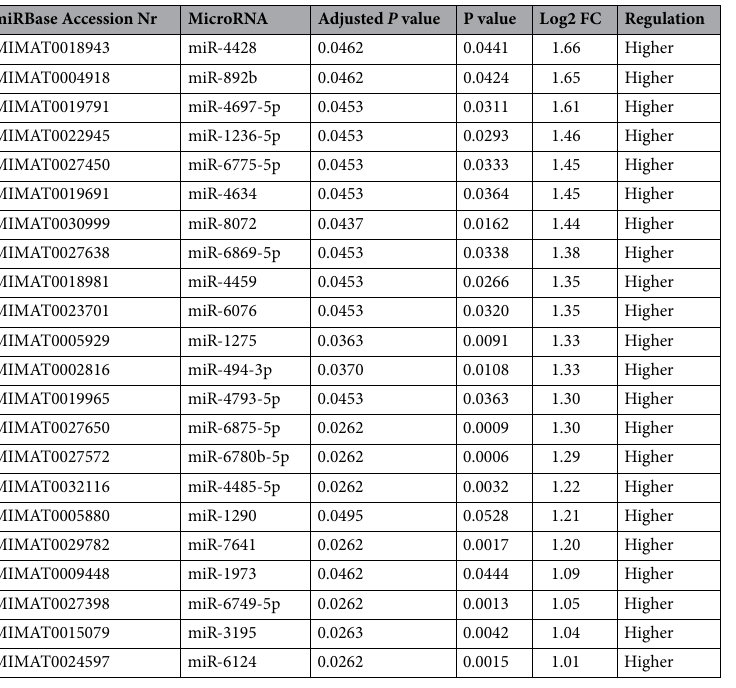
Table 2. Significantly abundant miRNAs in the blood of women presenting at an infertility clinic as determined by microarray (adjusted P < 0.05 and fold change ≥ 2). LAMH (n = 12) compared to NAMH group (n = 13) and HAMH (n = 13) compared to NAMH group (n = 13). Unpaired t test was used to calculate the P value. Benjamini–Hochberg correction for multiple testing was used to adjust the P value. Significant changes in abundance levels are shown with an adjusted P value < 0.05 and log2 fold change. LAMH low anti-Müllerian hormone levels, HAMH high anti-Müllerian hormone levels, NAMH normal anti-Müllerian hormone